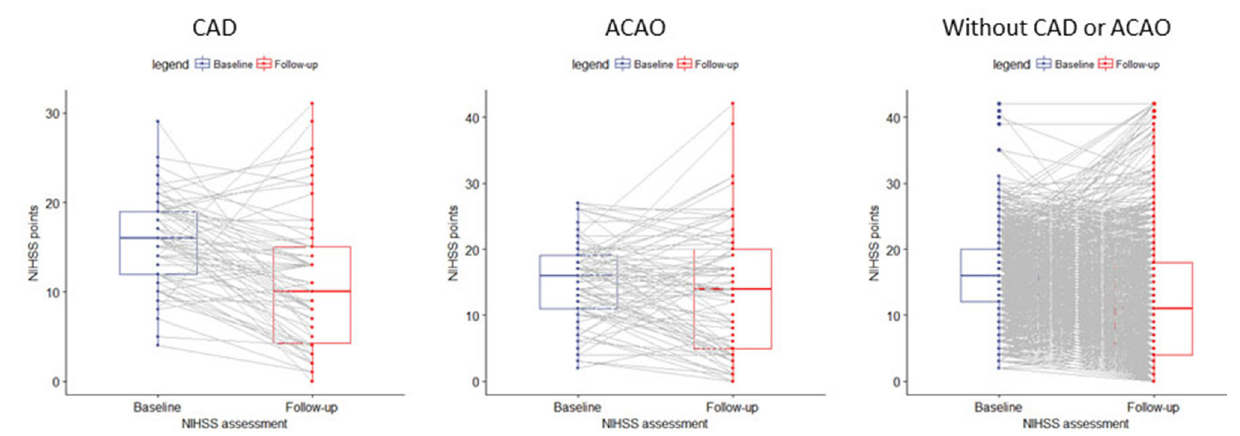
patients with CAD, progression of ischemic stroke (resp. 12.2% vs. 11.7%; p 1.00) nor symptomatic intracranial hemorrhage (5% vs. 6%; p 1.00) occurred more often than in patients without